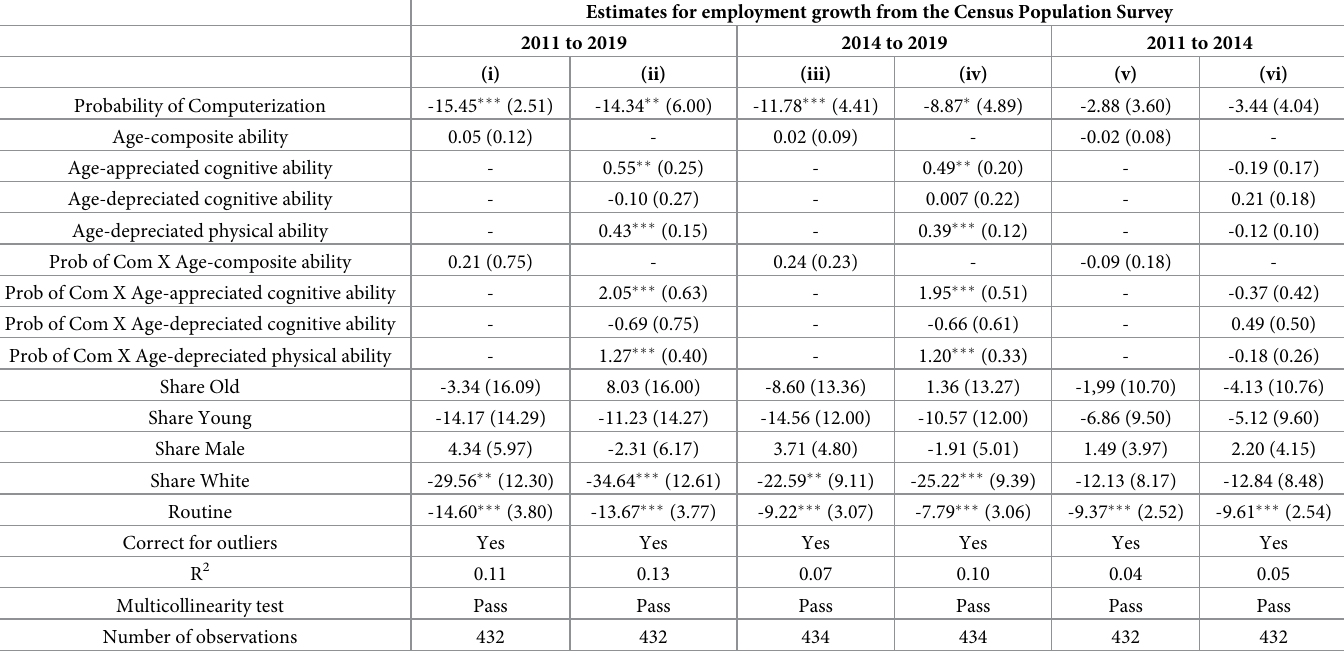
Table 3. The impact of the computerization and age-appreciation or age-depreciation on